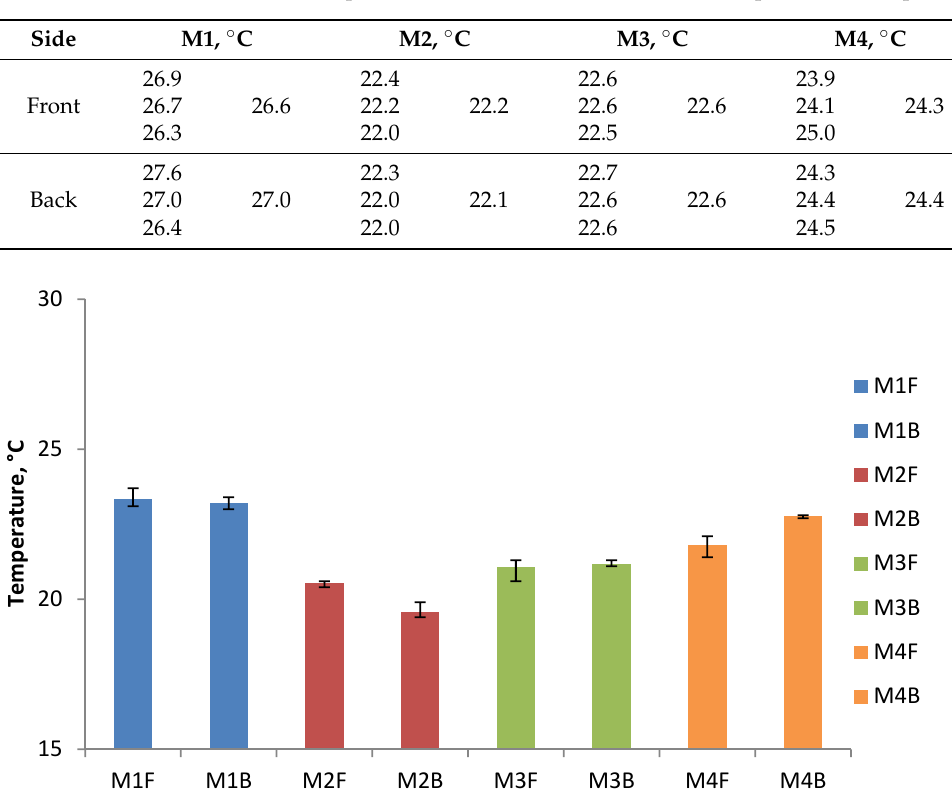
Table 2. The results of maximum temperature measurements on the surface of briquettes after briquetting.